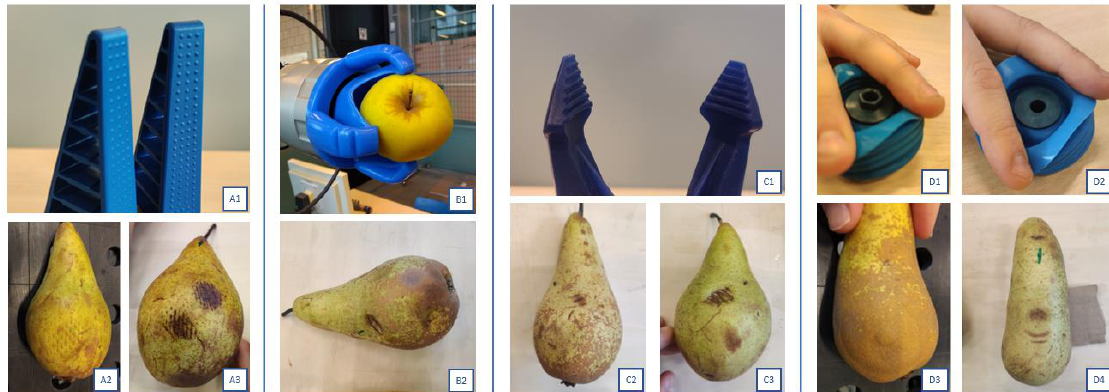
Figure 4. Overview of damage results. ( A1 ) FESTO finray with textured gripping surface; ( A2 ) damage caused by finray on day 0; ( A3 ) damage caused by finray on day 4; ( B1 ) the fingertips of the OnRobot gripper curling up into point contacts; ( B2 ) damage caused by OnRobot point contact on day 4; ( C1 ) piSoft with ribbed gripping surface; ( C2 ) damage caused by piSoft on day 0; ( C3 ) damage caused by piSoft on day 4; ( D1 ) original BBL60 fitting; ( D2 ) Customized BBL60 fitting; ( D3 ) customized BBL60 indentation on day 0; ( D4 ) suction spot caused by suction cups on day 4.